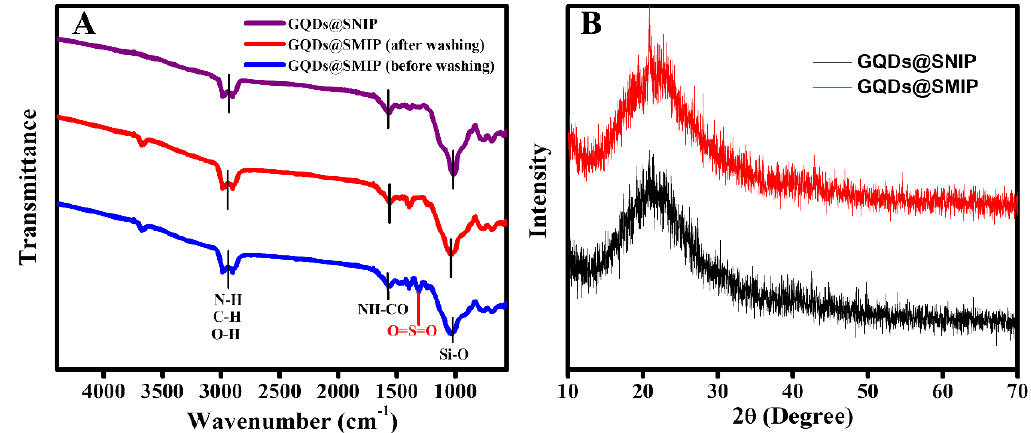
Figure 3. FTIRspectraofGQDs@SNIP,GQDs@SMIP(afterwashing), andGQDs@SMIP(beforewashing)( A ). Figure 3. FTIR spectra of GQDs@SNIP, GQDs@SMIP (after washing), and GQDs@SMIP (before XRD spectra of GQDs@SNIP and GQDs@SMIP ( B washing) ( A ). XRD spectra of GQDs@SNIP and GQDs@SMIP ( B ).